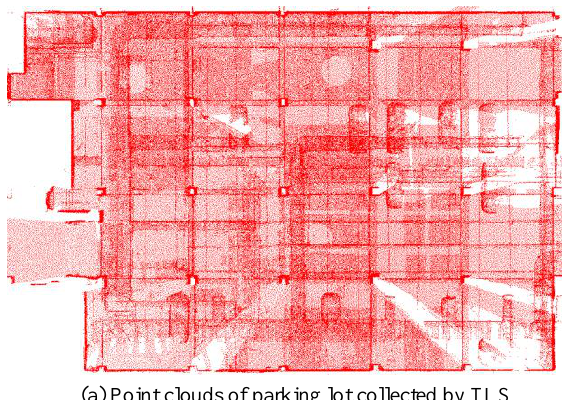
Figure 5. Outdoor mapping result in a road environment